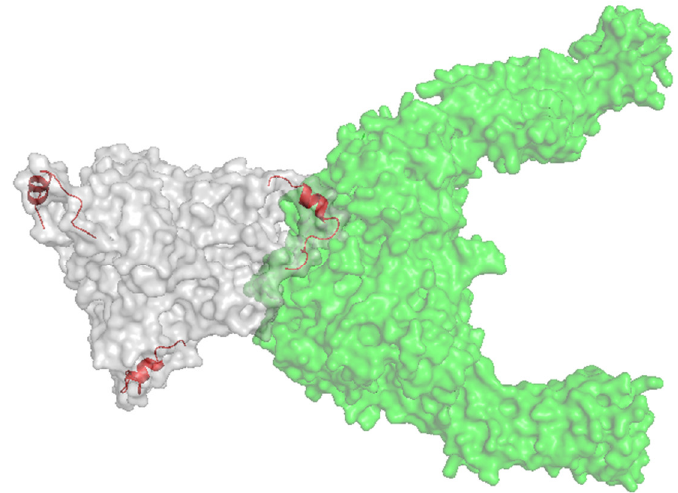
Figure 6. Ad5 knob (white) with the A20 peptide insertion (red) in complex with α v β 6 (green). Image created using PyMol.